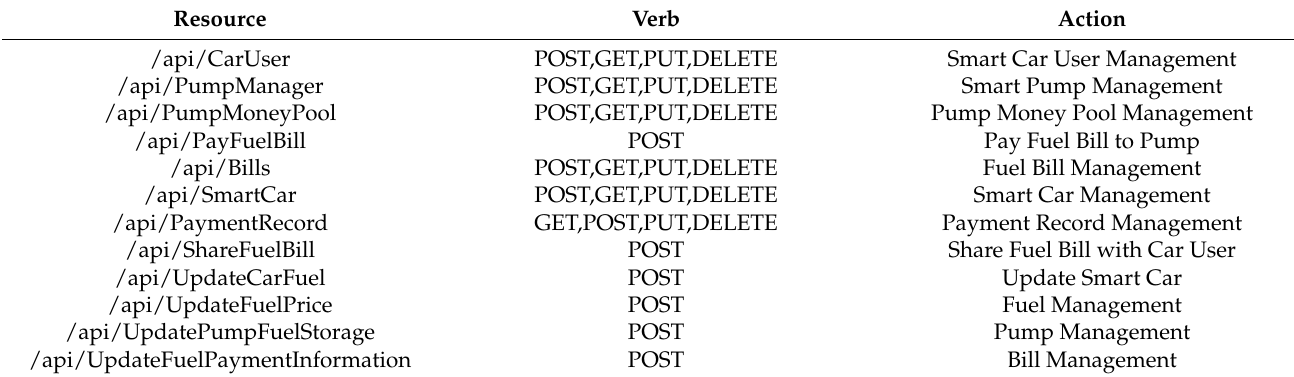
Table 2. HTTP request in the proposed